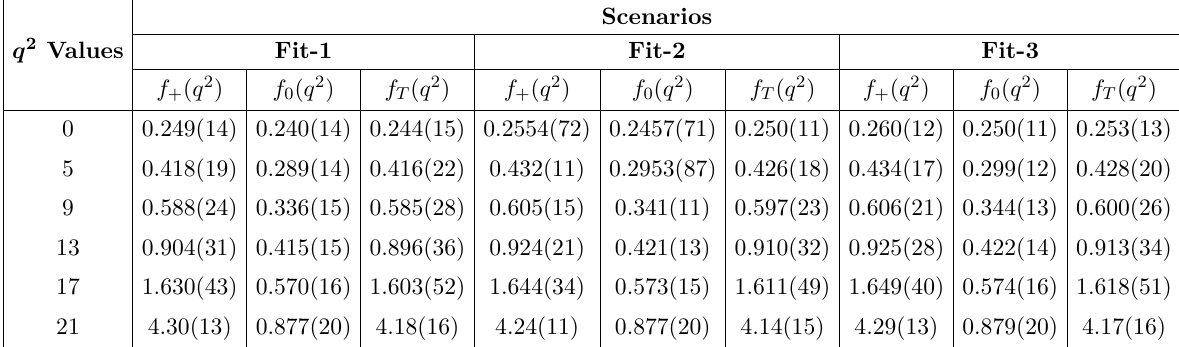
Table 10. Values of the different B → π form factors corresponding to a few q 2 values within the allowed kinematical region for the B → π semileptonic